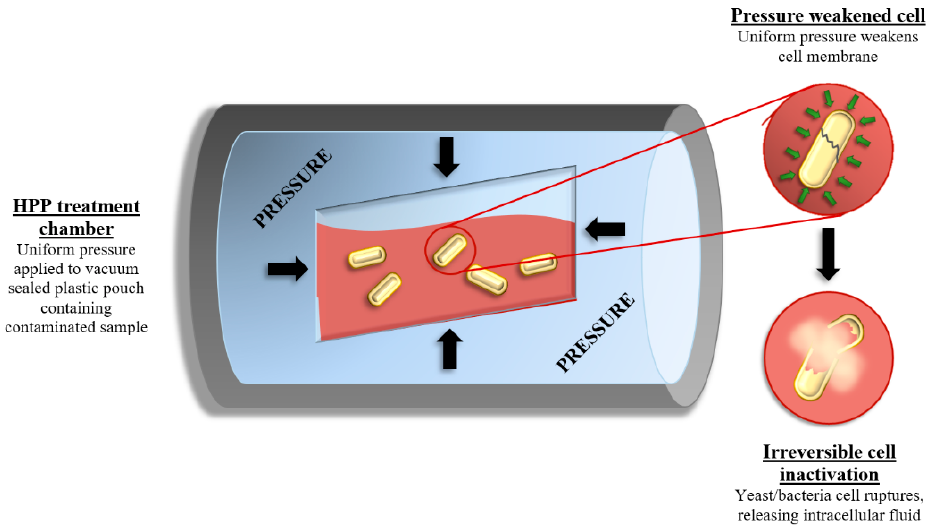
Figure 2. Diagram showing the high-pressure processing (HPP) inactivation of microorganisms in a beverage (extracted from Silva and van Wyk, 2021) [21].